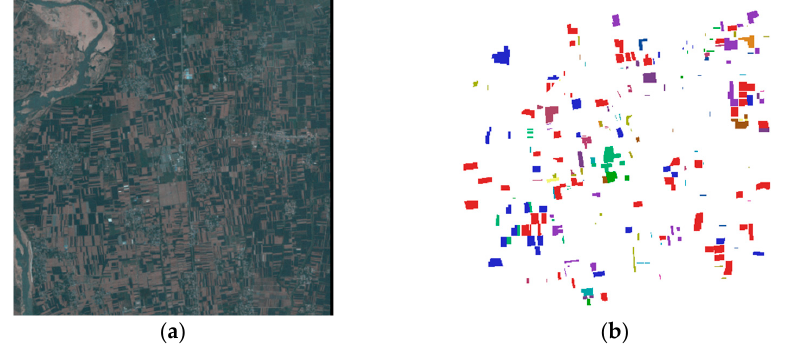
Figure 1. HL dataset false color images and ground truth. ( a ) three-band composite false color im- ages (23, 11, 7); ( b ) ground truth.